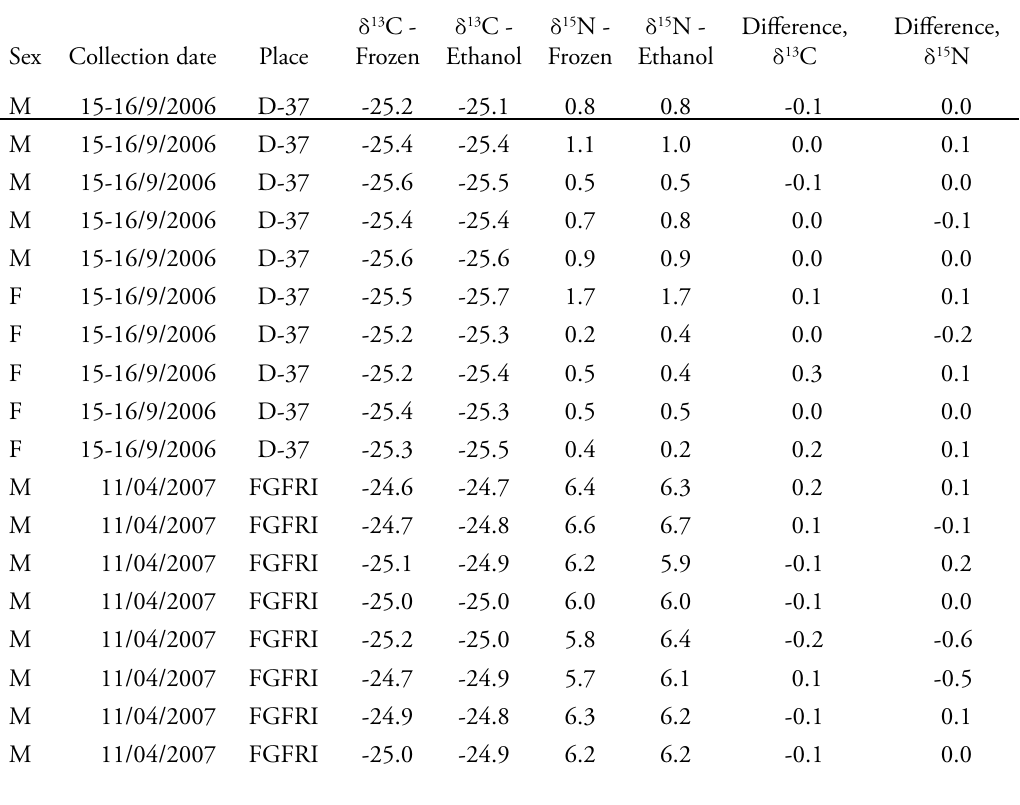
Table 1. Comparison of δ 13 C and δ 13 C values of reindeer whole blood samples preserved by freezing and in 70% ethanol. Values are expressed in ‰, relative to the appropriate standard (see